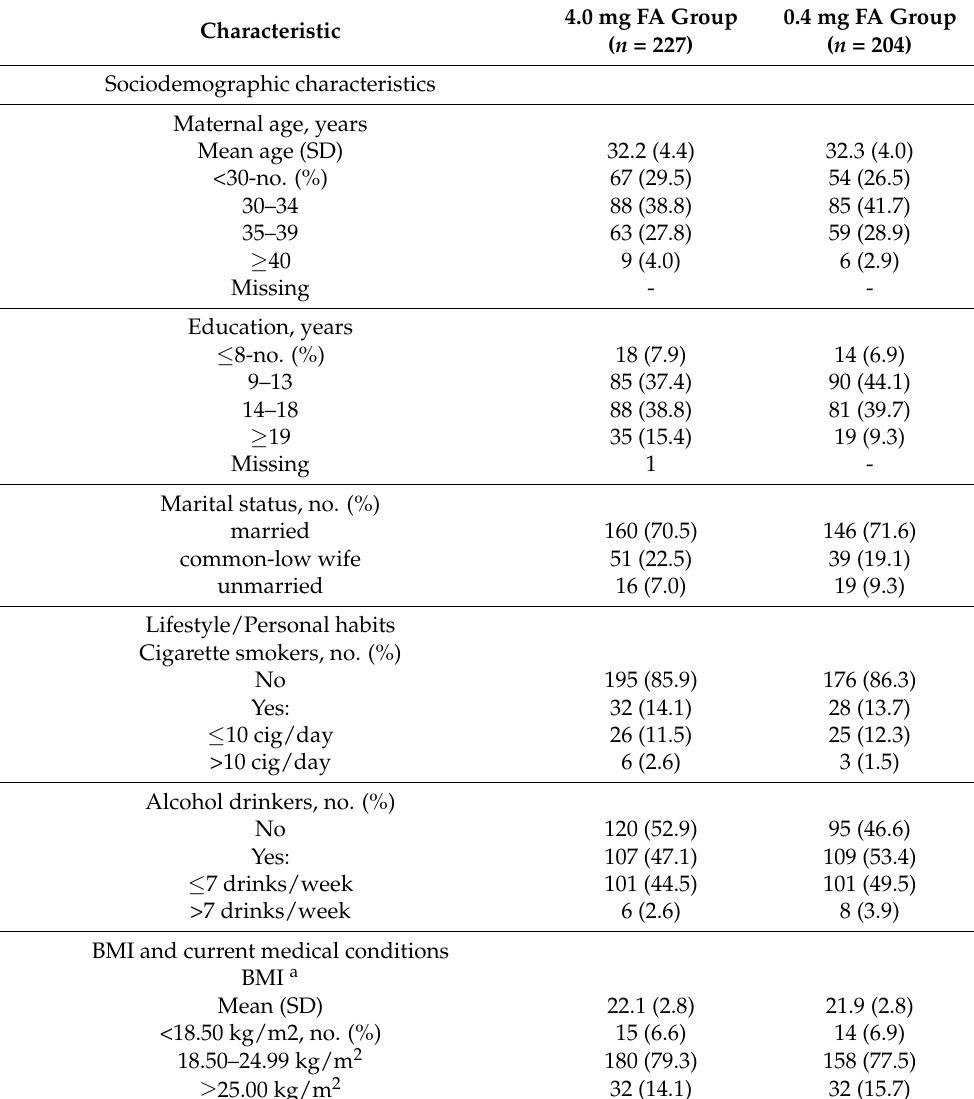
Table 1. Characteristics of the Trial Participants included in the